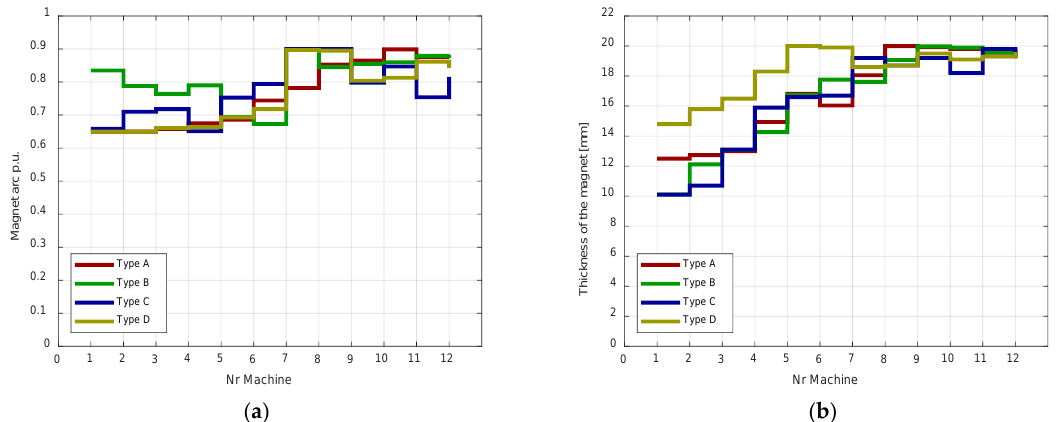
Figure 14. Permanent magnet arc ( a ) and thicknesses ( b ) of the machines belonging to the four Pareto fronts.